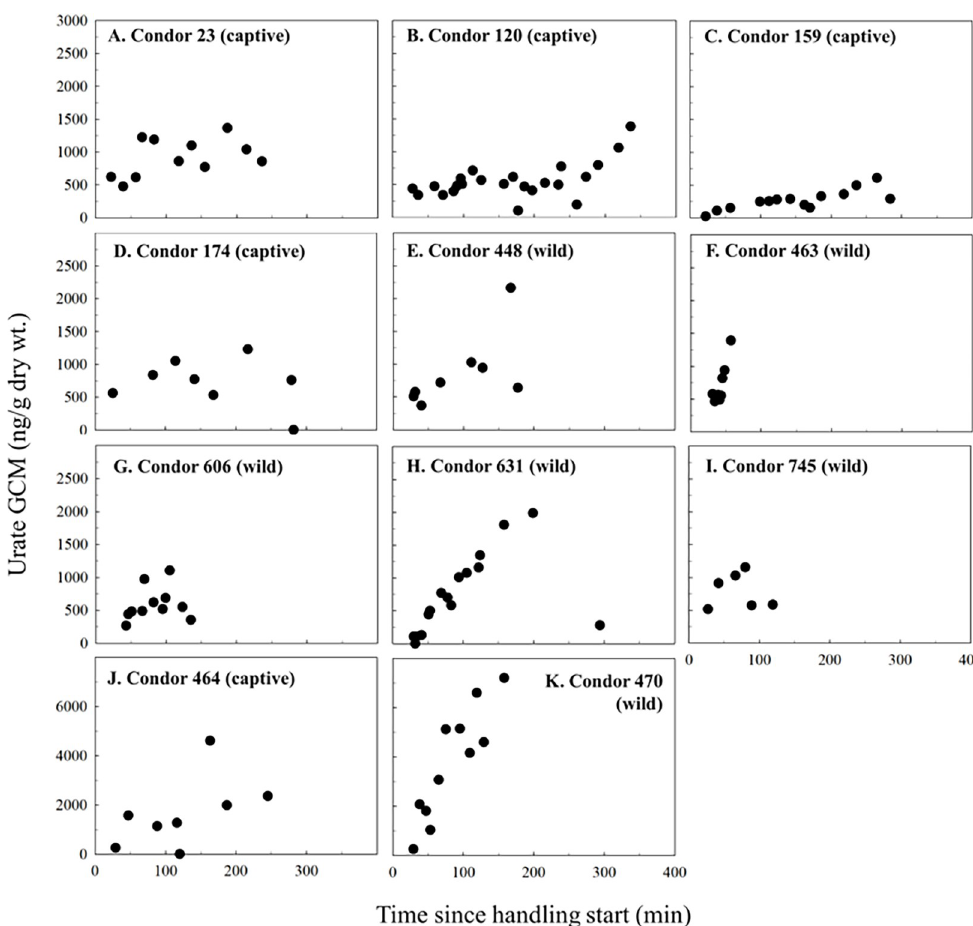
Fig 3. Condor urate glucocorticoid metabolite (GCM) concentrations significantly increased within 2 hours of a handling stressor. GCM concentrations (ng/g dry wt.) in condor urates collected sequentially following a physical handling and venipuncture event. Panels A-D and J are zoo-captive condors, while panels E-I and K are wild condors. X- axis shows the elapsed time since handling start; note y-axis scale difference between condor panels A-L versus J and K. See S7 Table for additional information on individual urate